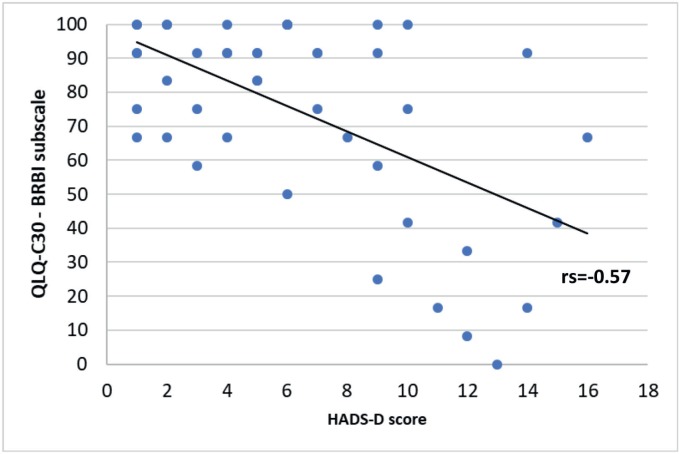
Correlation between HADS-D and the body image (BRBI) subscale of EORTC QLQ-C30.